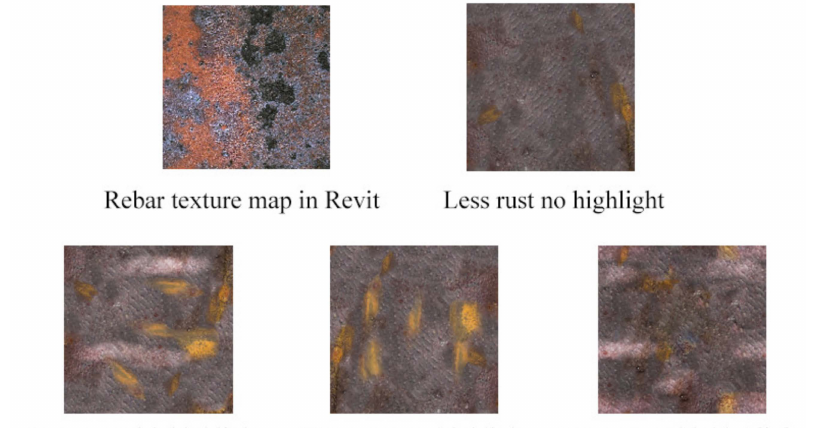
Figure 5. Rebar texture map.